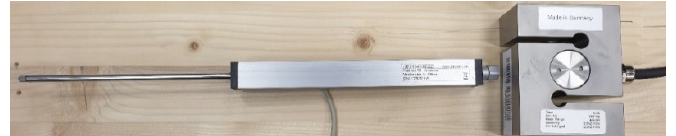
Figure 3. Strain gauge sensor (on the left); force gauge sensor (on the right).